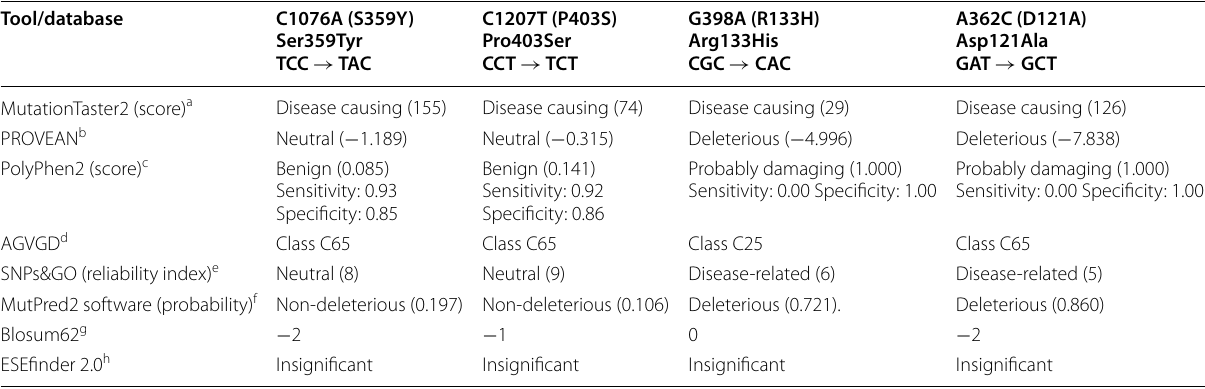
Table 1 Predicting the effect of detected